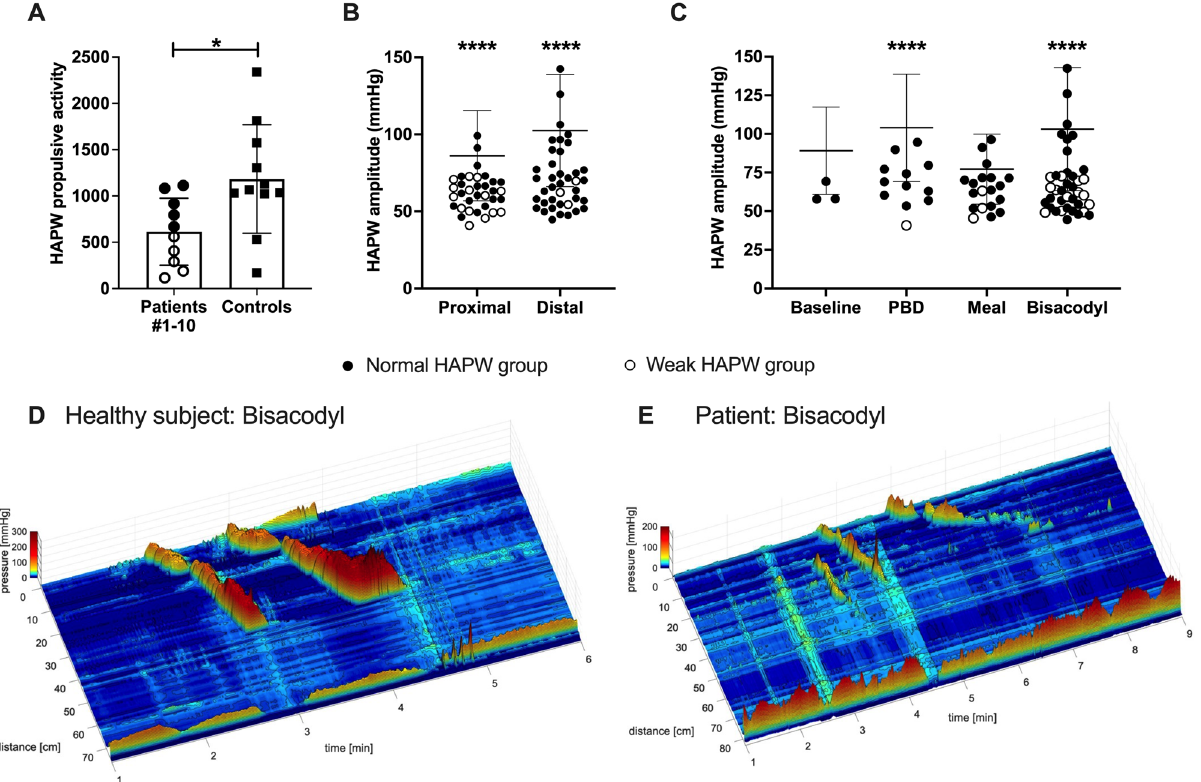
Figure 1. The amplitude of HAPWs and the HAPW Propulsive Activity was lower in patients compared to that of healthy controls 20 . ( A ) Propulsive activity is defined as the average amplitude of HAPWs x the number of HAPWs present during the entire protocol. Patients (N = 10) were separated into a weak and a normal HAPW group based on whether their HAPW propulsive activity was within one standard deviation of the healthy control (N = 11) mean value. Overall, patients had significantly lower HAPW propulsive activity than healthy subjects. Patients without HAPWs (Patients #11–14) were excluded. * P < 0.05. ( B ) Amplitude of HAPWs that started in the proximal and the distal colon (left colon). Patients (N = 14, n = 73) showed significantly lower proximal and distal colon HAPW amplitude than healthy subjects(N = 19, n = 185). Lines show mean ± SD of HAPWs in healthy subjects. ( C ) HAPW amplitude in patients during baseline, in response to proximal balloon distention (PBD), in response to a 1000 kcal meal, and rectal bisacodyl administration. Patients (N = 14, n = 73) showed significantly lower HAPW amplitude than healthy subjects (N = 19, n = 185) in response to PBD and rectal bisacodyl. Lines show mean ± SD of HAPWs in healthy subjects. **** P < 0.0001. ( D ) Typical map of HAPWs observed in healthy subjects. The HAPWs that propagated from the proximal ascending colon (at 0 cm) and terminated in the descending colon (at 38 cm) were evoked by rectal bisacodyl. The anal sphincter (at 72 cm) relaxed in association with each HAPW. ( E ) Typical map of HAPWs observed in a patient. HAPWs were of lower amplitude compared to healthy subjects. These HAPWs stimulated by rectal bisacodyl in patient #2 propagated from the proximal descending colon (at 0 cm) to the sigmoid colon (at 33 cm). Only one HAPW was associated with anal sphincter (at 78 cm) results of a positive balloon expulsion test, delayed left colon to pelvic region transit, or both (Patients #1, 8–13, Supplementary Table S1). Associations between left colon hypertonicity, sphincter of O’Beirne activity and coccyx injury.